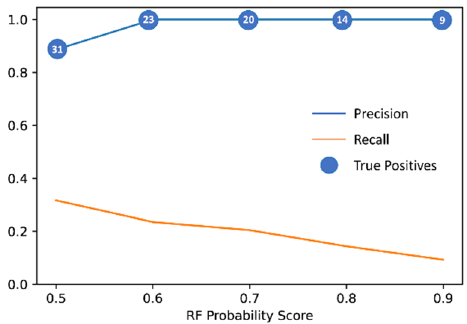
Figure 1. Performance evaluation of RF model with different classification thresholds, based on test set prediction. The test set consists of 314 instances of which 98 active. set prediction. The test set consists of 314 instances of which 98